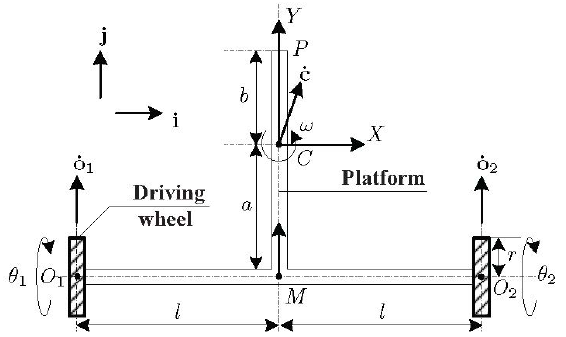
Figure 5. Diagram of a